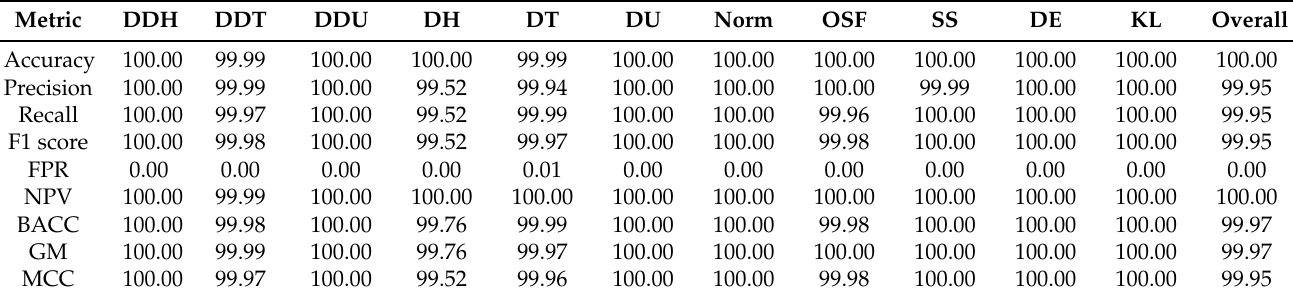
Table 6. Classification performance of S-DRNN model.